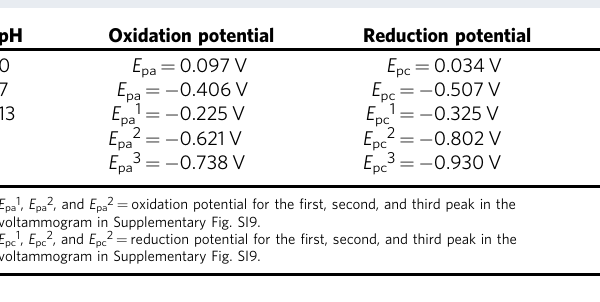
Table 1 Electrochemical data including the oxidation ( E pa ) and reduction ( E pc ) potentials for TRYP-SO 3 H in different pH of the supporting electrolyte at T = 293 K.